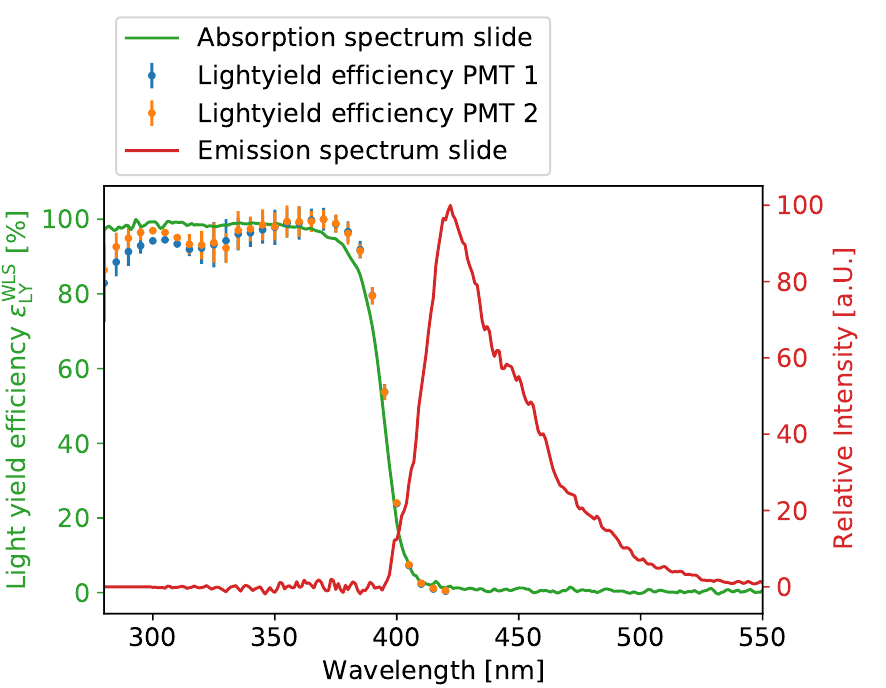
Figure 11. Absorption (green) and emission spectra (red) of a WLS-coated quartz slide. The light yield efficiency (cid:101) WLS measured on the prototype tube is shown in blue and orange. The methodologies of LY the experiments are described in Refs.